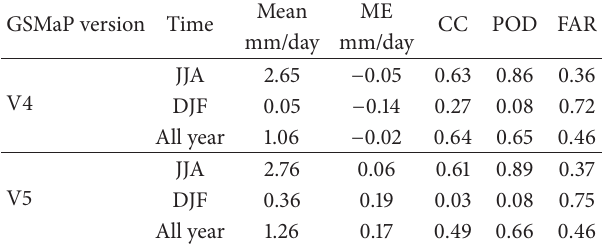
Table 4: Validation statistics comparing the performances of GSMaP rainfall estimates over high latitude regions (Region